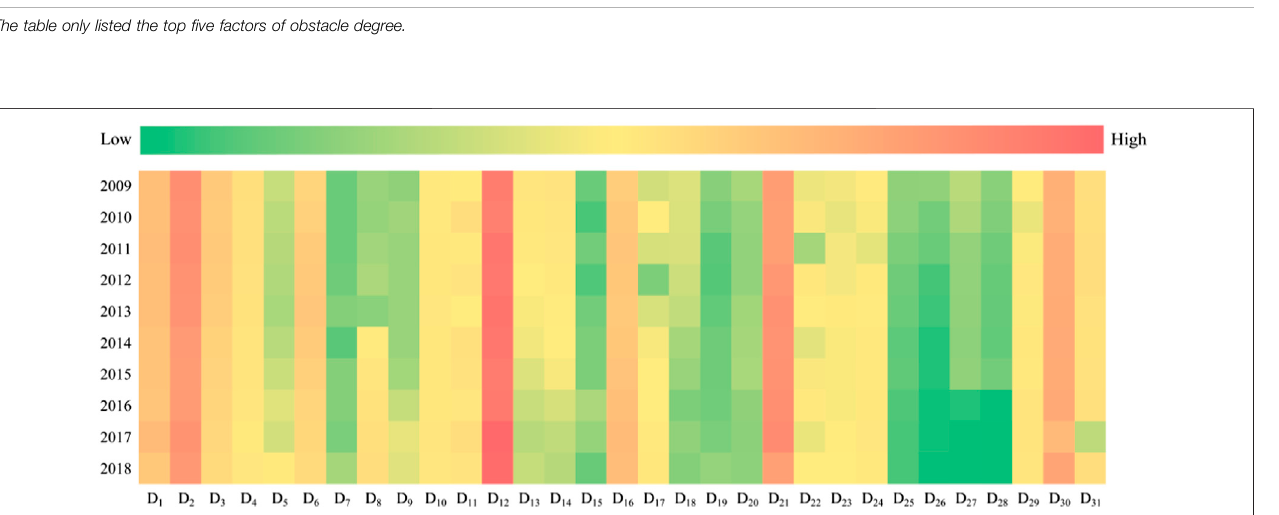
FIGURE 5 | The obstacle degree of 31